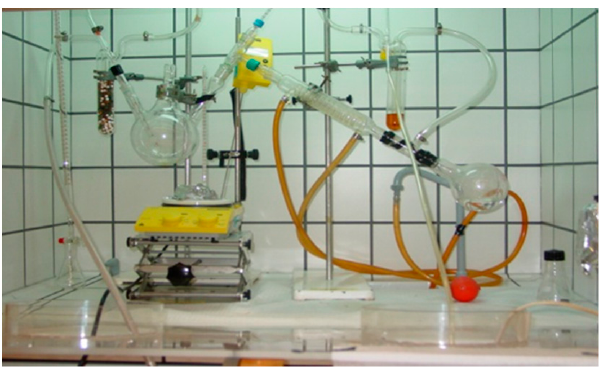
Figure 8. Installation used for the synthesis of the CZTS precursor solution at the authors’ facili- ties.